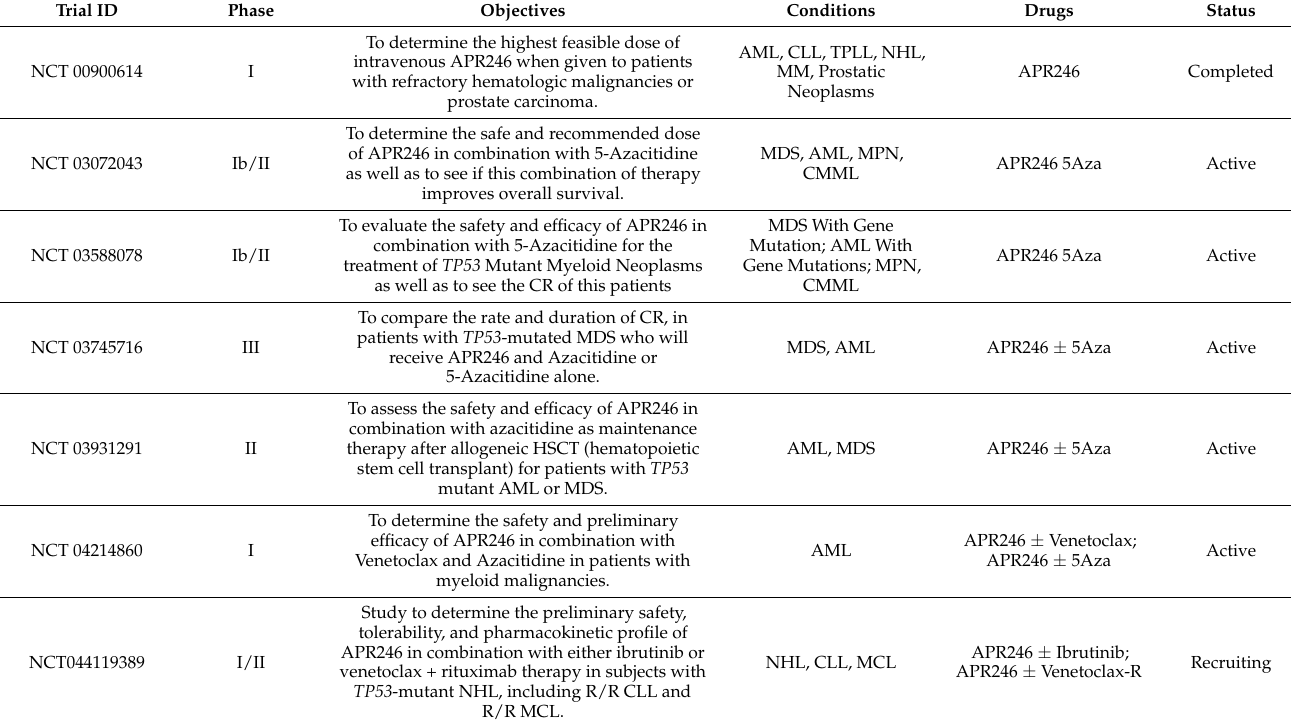
Table 2. Clinical trials with APR-246 in hematological